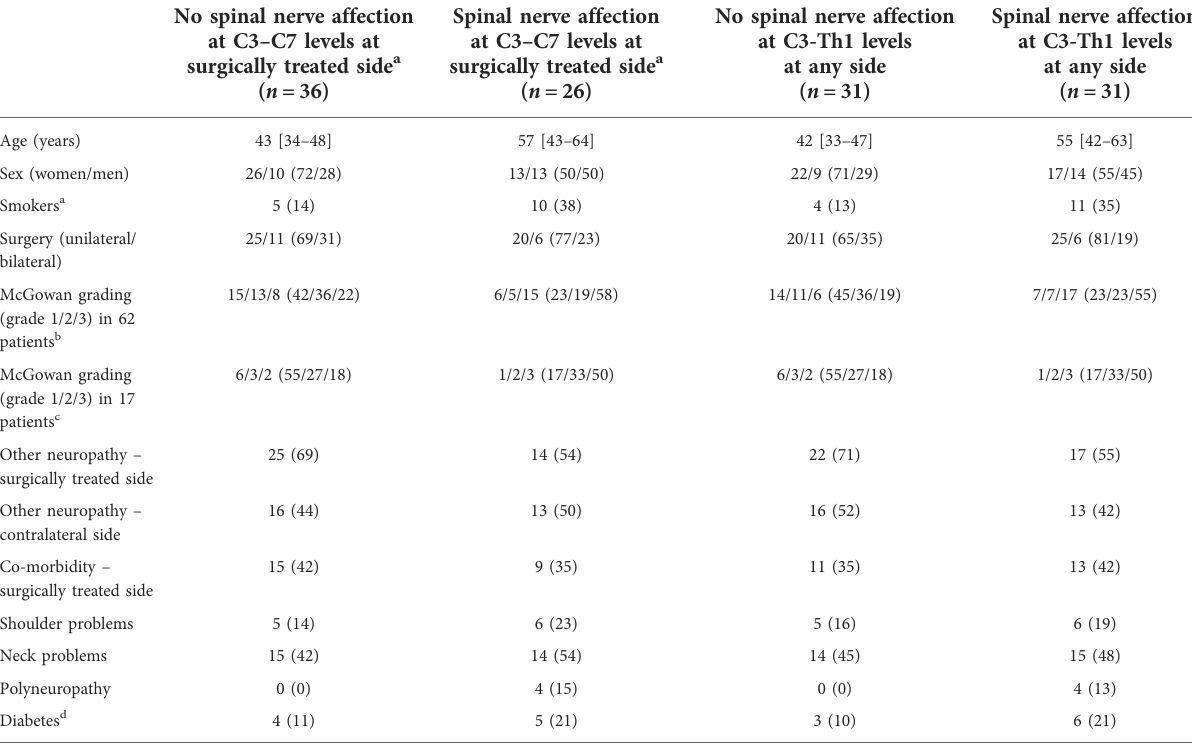
TABLE 3 Cervical spinal nerve root affection at surgically treated side and at any side of patients with ulnar nerve compression at the elbow and with available MRI. No spinal nerve affection